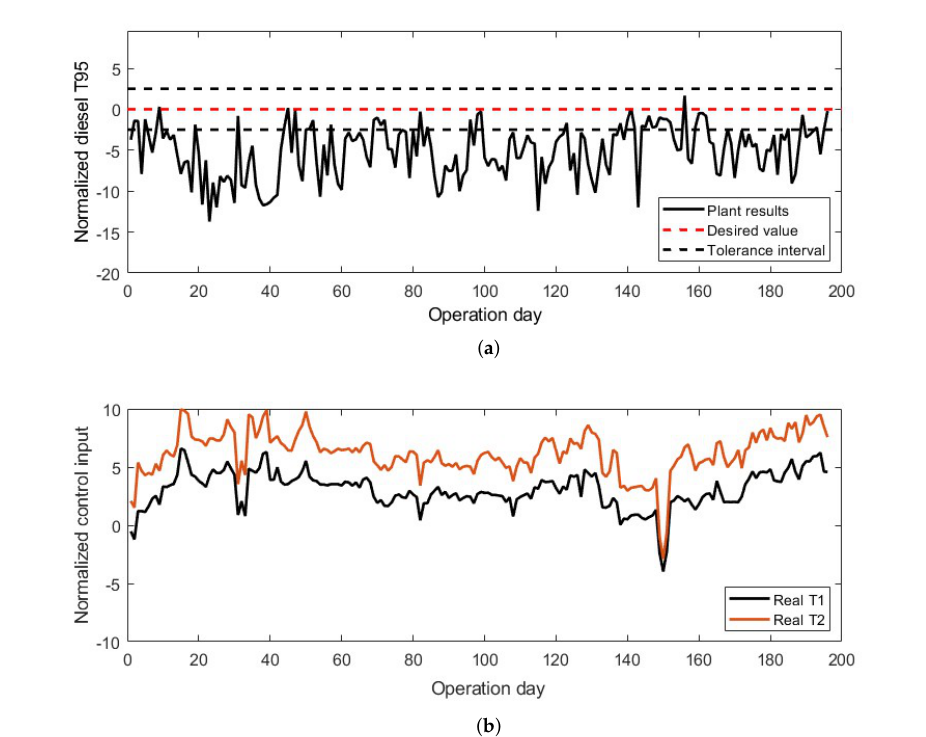
Figure 8. Real plant measurements of the independent test data. ( a ) Diesel T95 lab measurements. ( b ) Reactor temperatures.